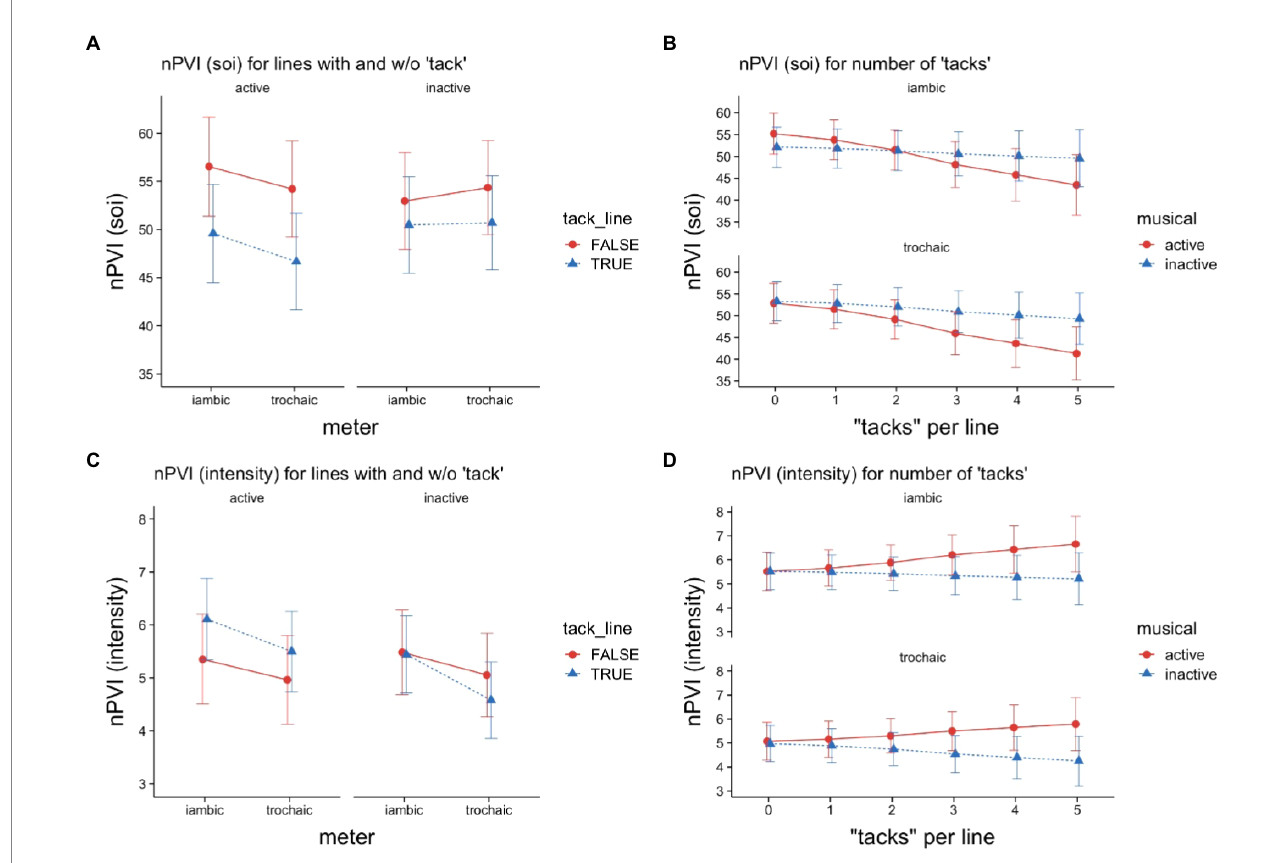
FIGURE 3 Illustration of analyses on the line level. SOI-based nPVIs (A,C) and intensity-based nPVIs (B,D) , as a function of meter (iambic vs. trochaic), musical activity (active vs. not active), and tack line [whether or not one or more tacks are present in a line (A,B) ], or tacks per line (the number of tacks in a line), ranging from low = 0 to high = 5 (B,D) . The whiskers depict 95% confidence